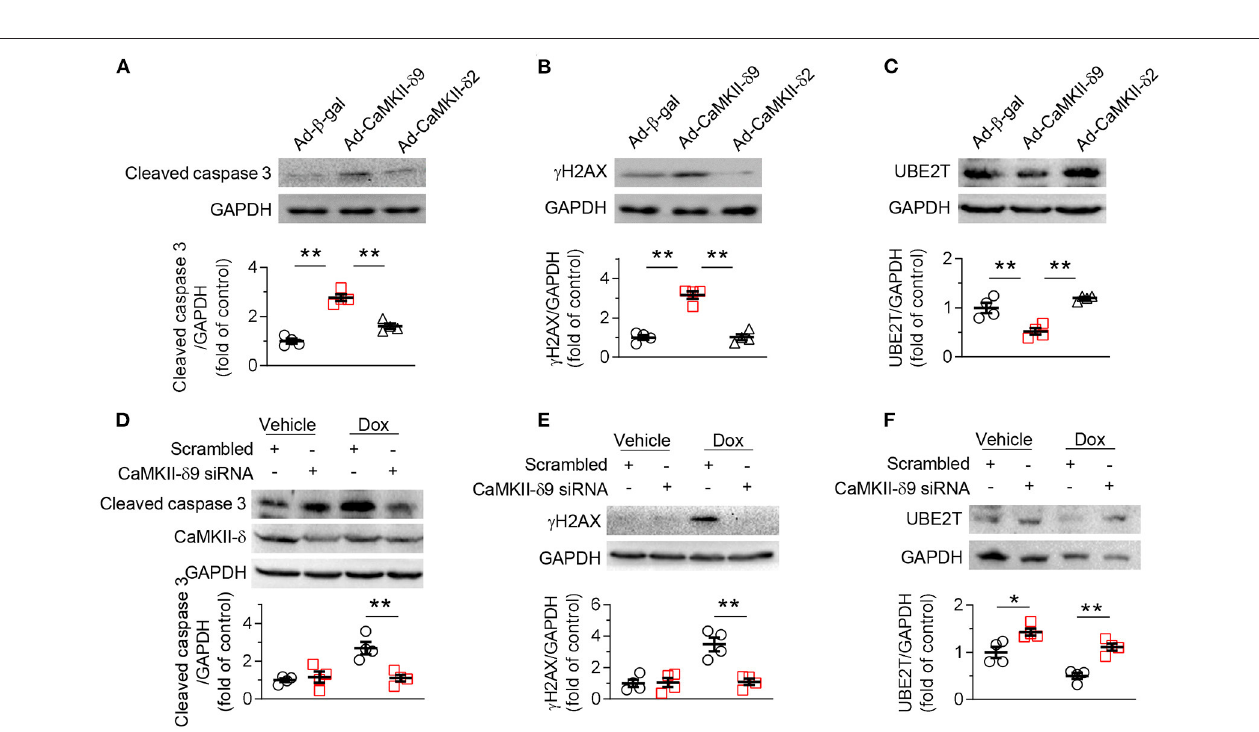
FIGURE 4 | CaMKII- δ 9 is abundant in the adult hearts of different species. (A) Representative western blots and statistical data showing the levels of CaMKII- δ 9 in the hearts of rhesus monkey and human, neonatal rat ventricular myocytes (NRVMs), adult mouse together with rat ( n = 4). Data are mean ± S.E.M. ** P < 0.01; one-way ANOVA. (B) Amino acid sequences of the peptides encoded by the exon 16 of CaMKII- δ of human, mouse, rhesus monkey and rat.